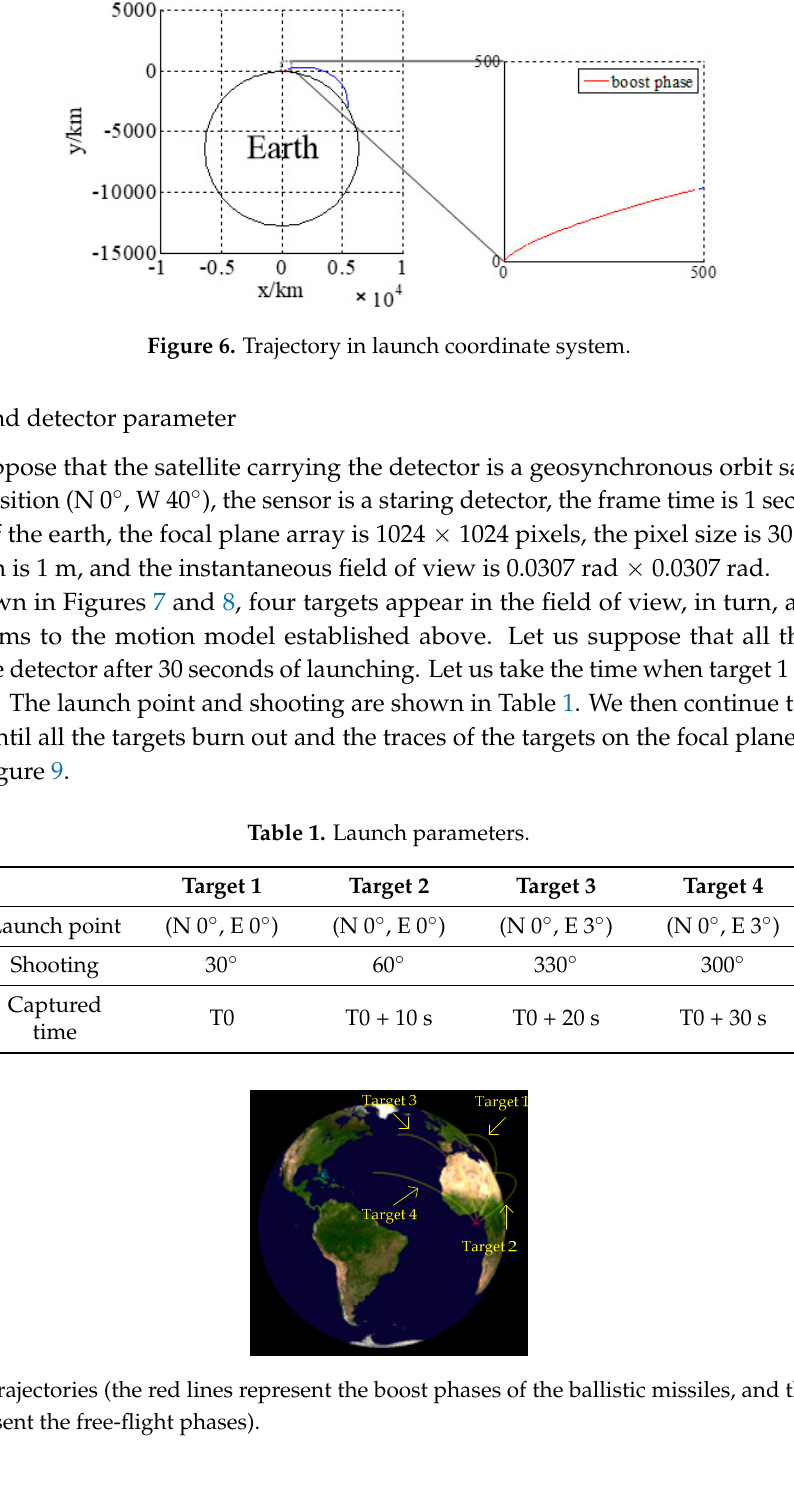
Figure 8 . Detection scenario (the left picture is a panorama and the right one is a partial enlargement. The blue circle represents the detector orbit, the red ★ represents the detector, and the green line represents the line of sight). Figure 9. Traces of the targets on the focal plane. We can assume that the number of clutters on the focal plane obeys a Poisson distribution with a parameter of 10, and all the 181 s measurements of the scene are shown in Figure 10. Figure 10a shows all the measurements in the whole field of view of the detector. To make the local details clearer, Figure 10b shows an enlargement of the dotted box in Figure 10a, and Figure 10c shows an enlargement of the dotted box in Figure 10b. The measurement is a rectangular region corresponding to the pixel, as can be seen clearly in Figure 10c.